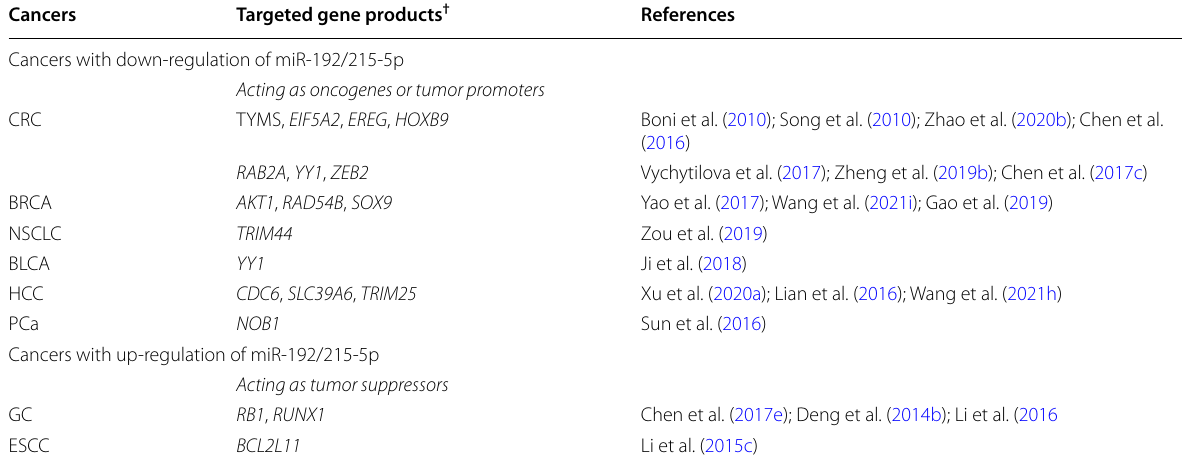
Table 3 Major genes targeted by miR-192-5p and miR-215-5p in various types of